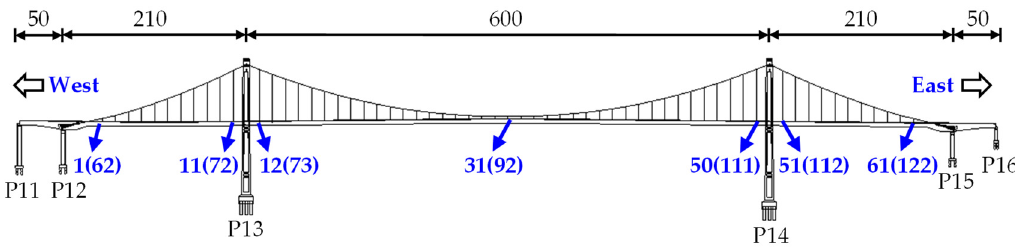
Figure 5. Layout of a long-span suspension bridge and numbering of hangers (unit: m).